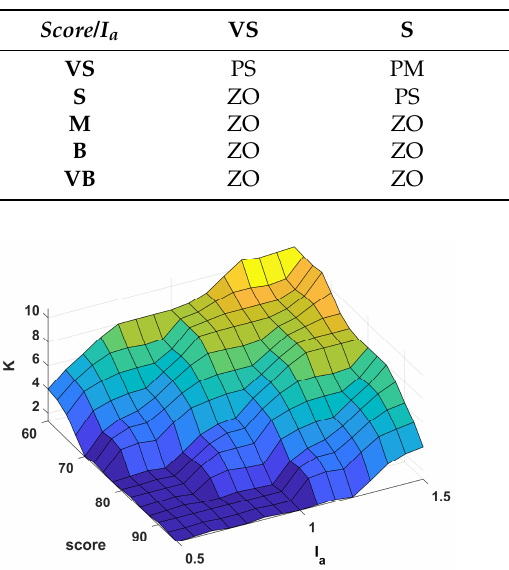
Table 2. Fuzzy rule table.